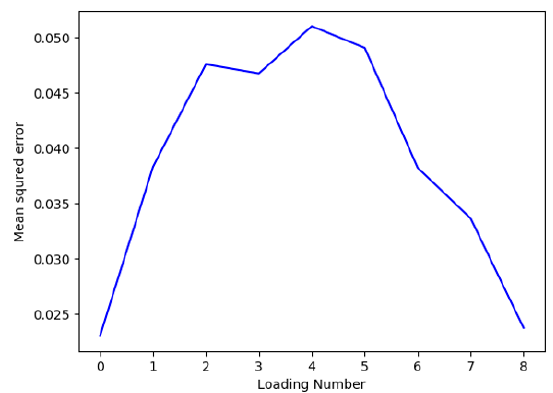
Figure 6. Mean squared error measured using five-fold cross-validation.